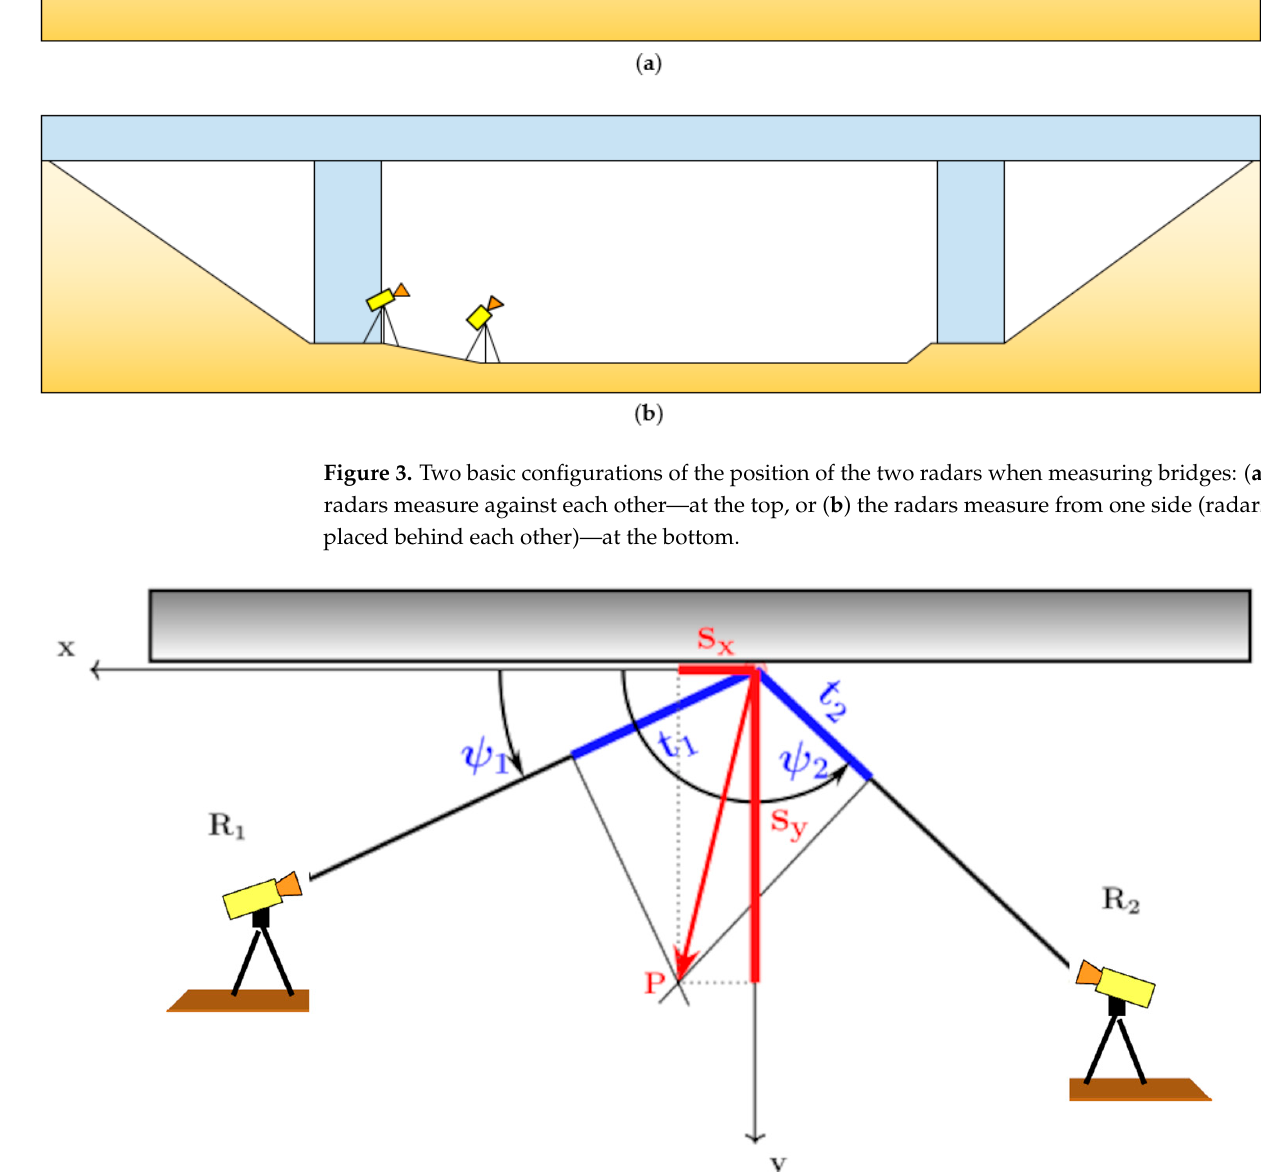
, 𝑡 and (cid:2869) (cid:2870)